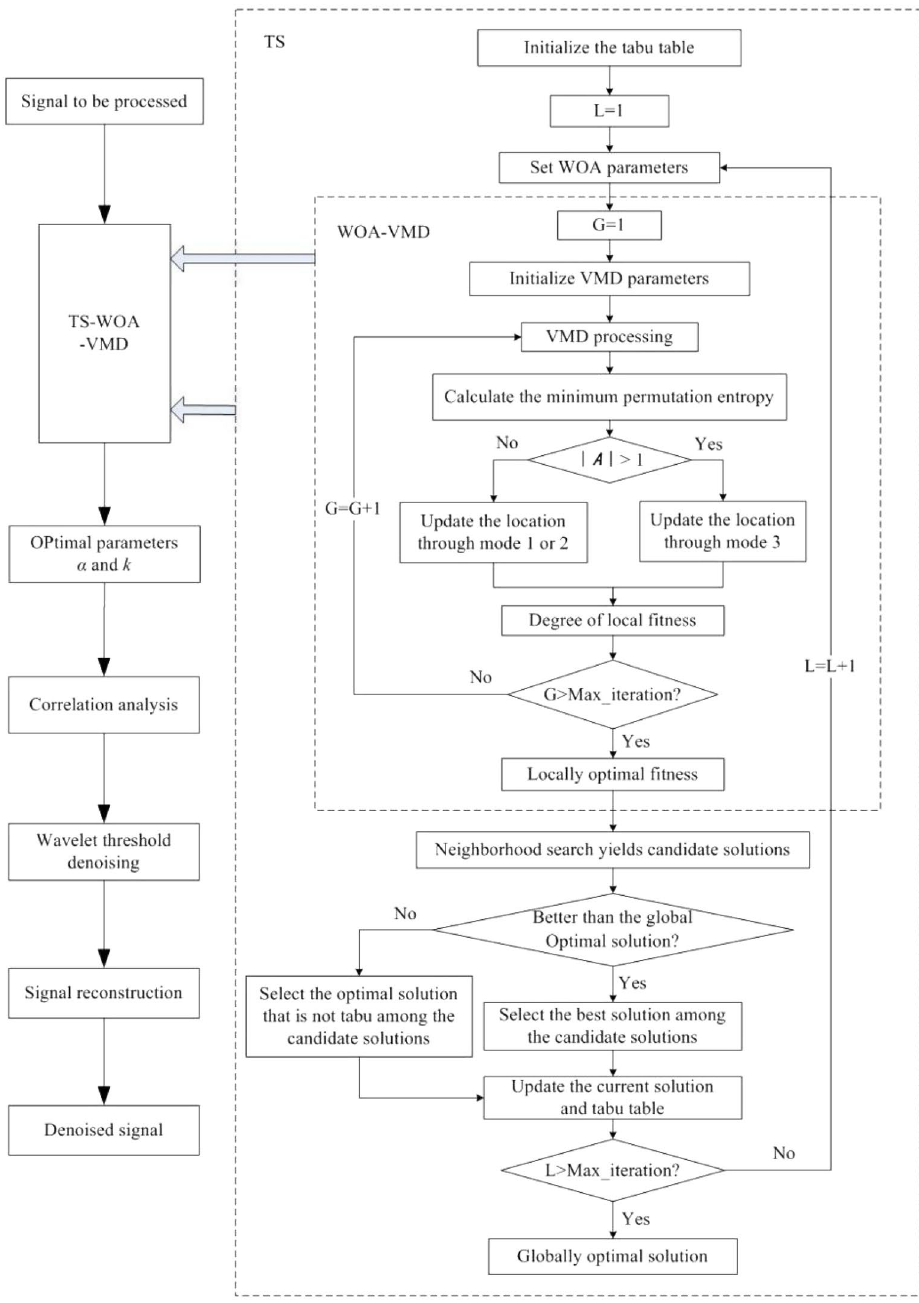
Figure 1. The denoising process based on the proposed